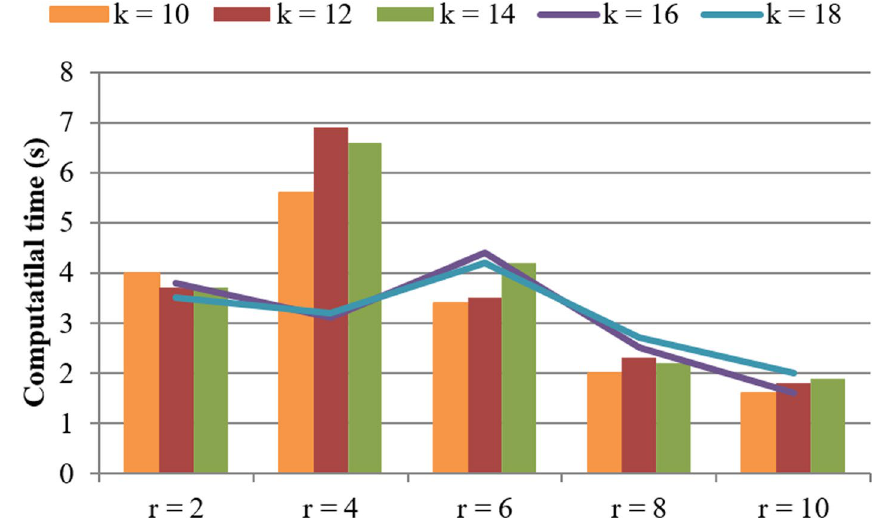
Fig. 6 Computational time of our algorithm (w.r.t. r and k